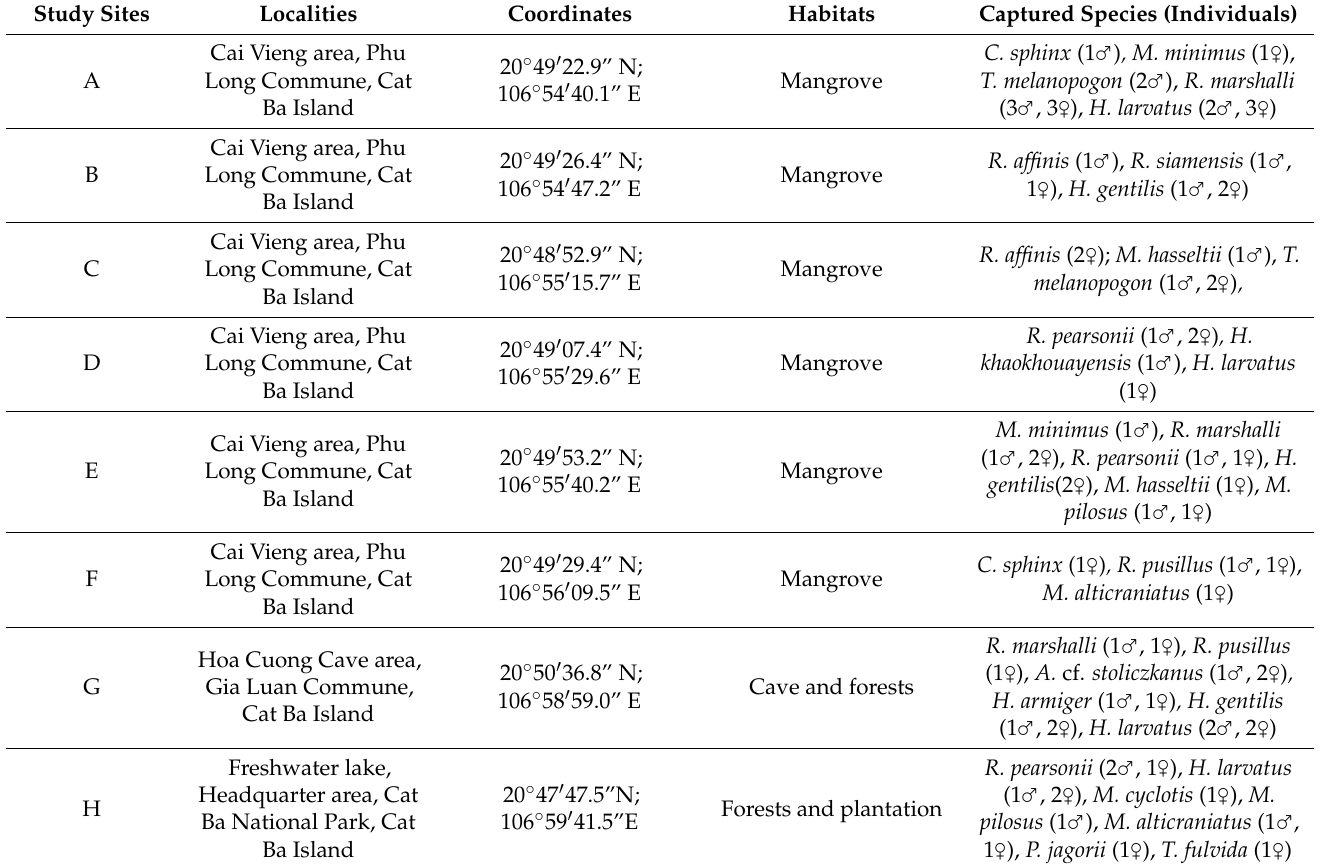
Table 1. Bat species abundance in the study sites in